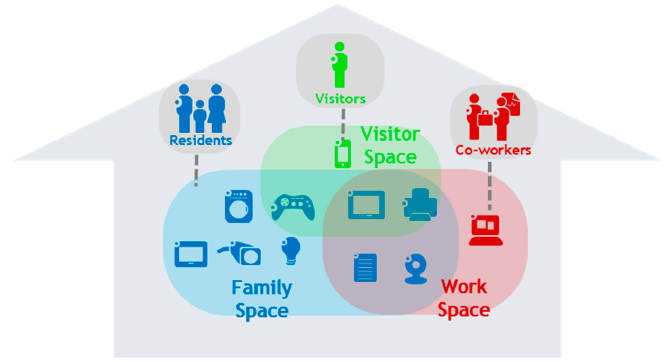
Figure 1. Virtual Spaces regroup and connect resources of a Virtual Place.